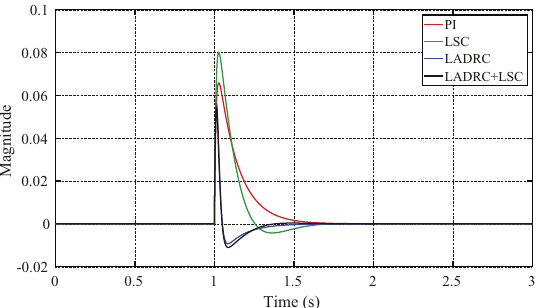
Figure 11. Disturbance rejection capabilities of the developed controllers.